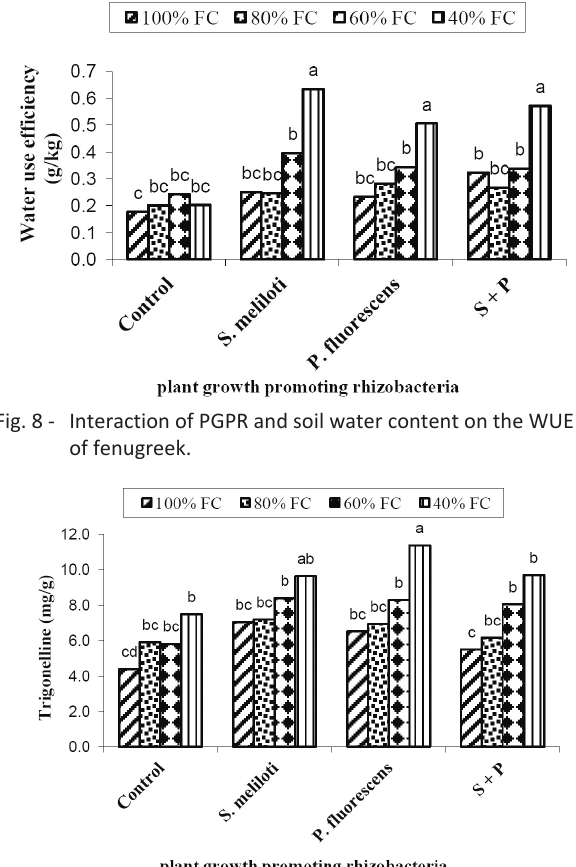
fig. 9 - Interaction of PGPR and soil water content on the Trigo- nelline of fenugreek seed.